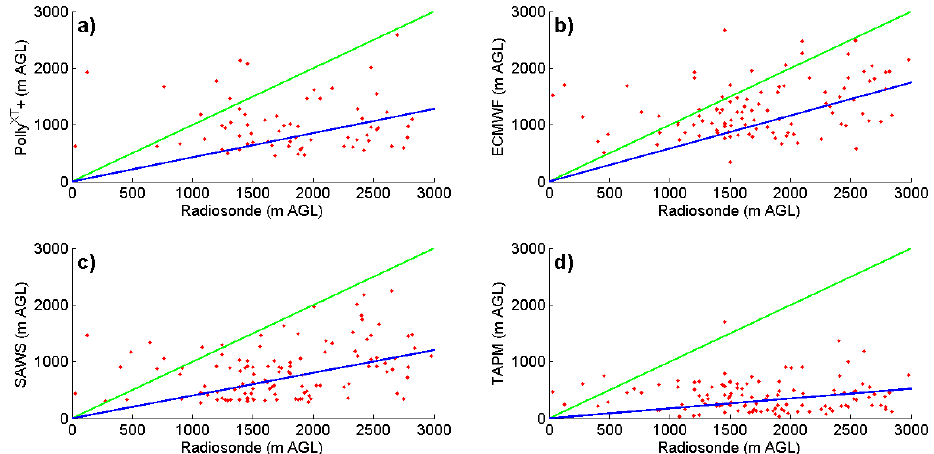
Fig. 4. Scatter plots for comparing Polly XT (a) , the ECMWF (b) , SAWS (c) and the TAPM model (d) to daytime radiosonde observations in the comparison period. Blue and green lines mark linear fit to the data and 1:1 correlation, respectively.